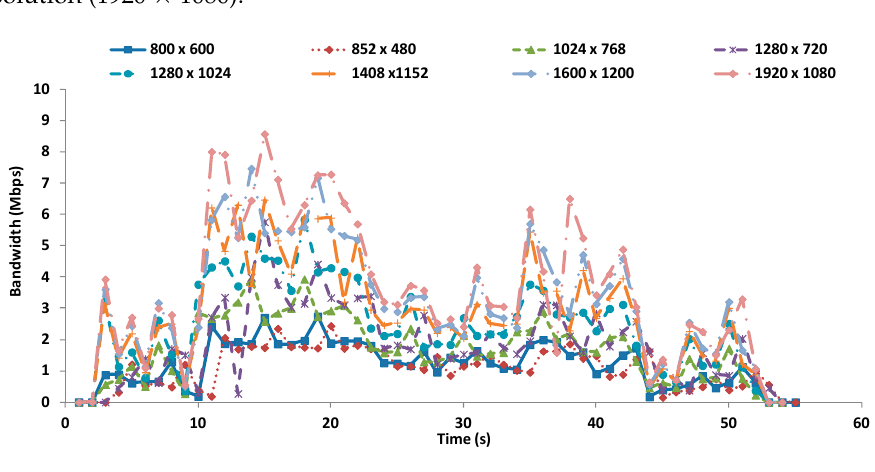
Figure 3. Bandwidth for videos at 30 fps.